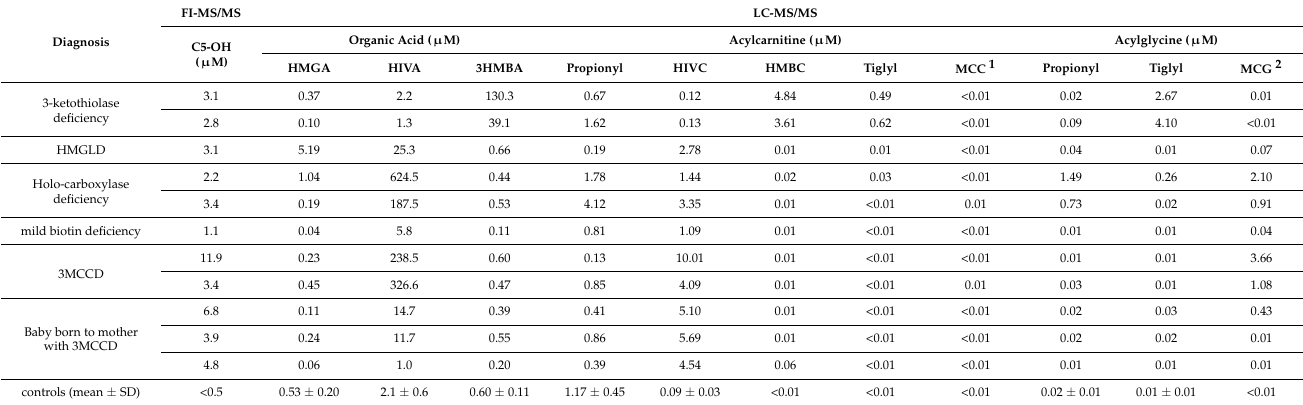
Table 5. Organic acids, acylcarnitines, and acylglycines in DBSs from newborns with high C5-OH levels.